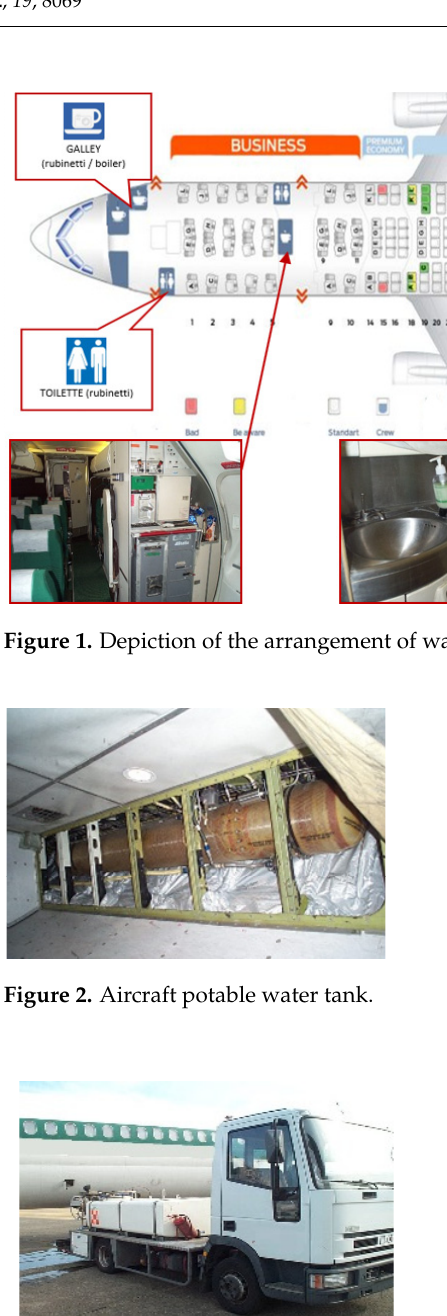
Figure 3. Airport water service trucks.